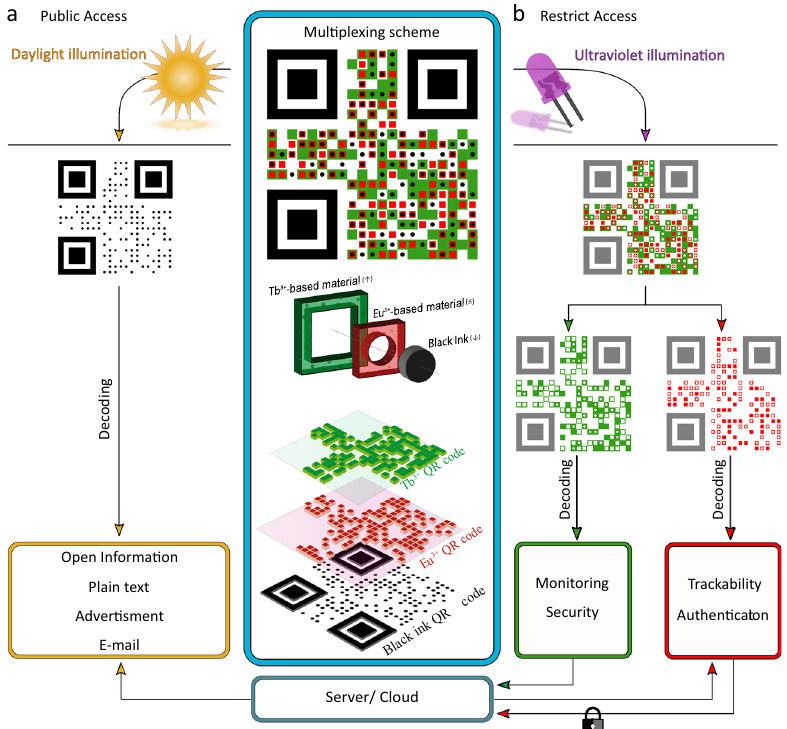
Fig. 1 Schematic of the proposed super -modules and multiplexing process. The QR codes are aggregated into a single one (spatial multiplexing) where the modules fi t perfectly one inside the others ( s -modules). The QR code contains 3 levels of information due to use of 3 independent inks (colour multiplexing) and shapes, allowing: a public access, read with ambient light, providing information to the user through the applications available at any mobile device and b restricted access with illumination UV/blue LED, read via dedicated applications/devices, that enable the monitoring and security, triggering alerts thought the establishing of an encrypted connection to a